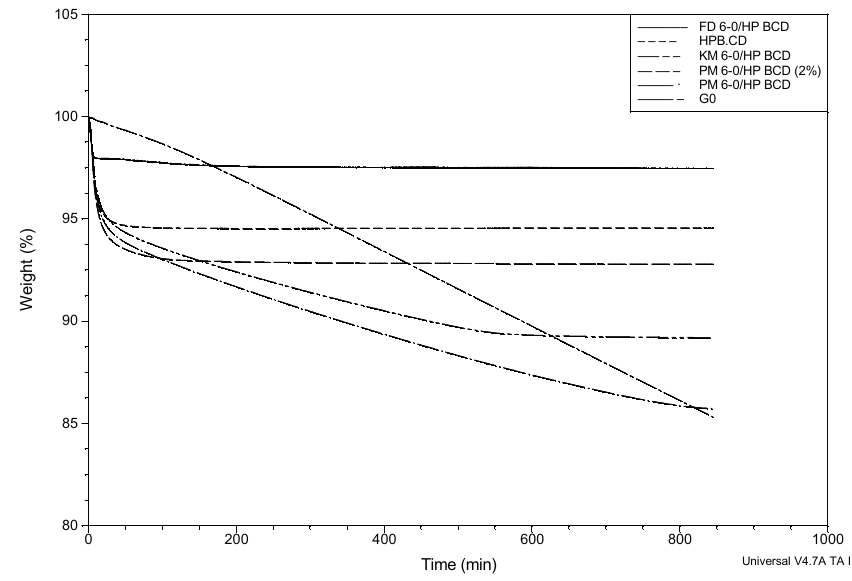
Figure 7. Isothermal time-dependent TGA curves of: pure G-0 (broken dash), HP- β -CD (short dash), physical mixture (PM) G-0/HP- β -CD (2%) (dash), physical mixture (PM) G-0/HP- β -CD (8.8%) (dash dot), kneaded mixture (KM) G-0/HP- β -CD (8.8%) (broken double dash) and freeze-dried (FD) G-0/HP- β -CD (2%) (solid